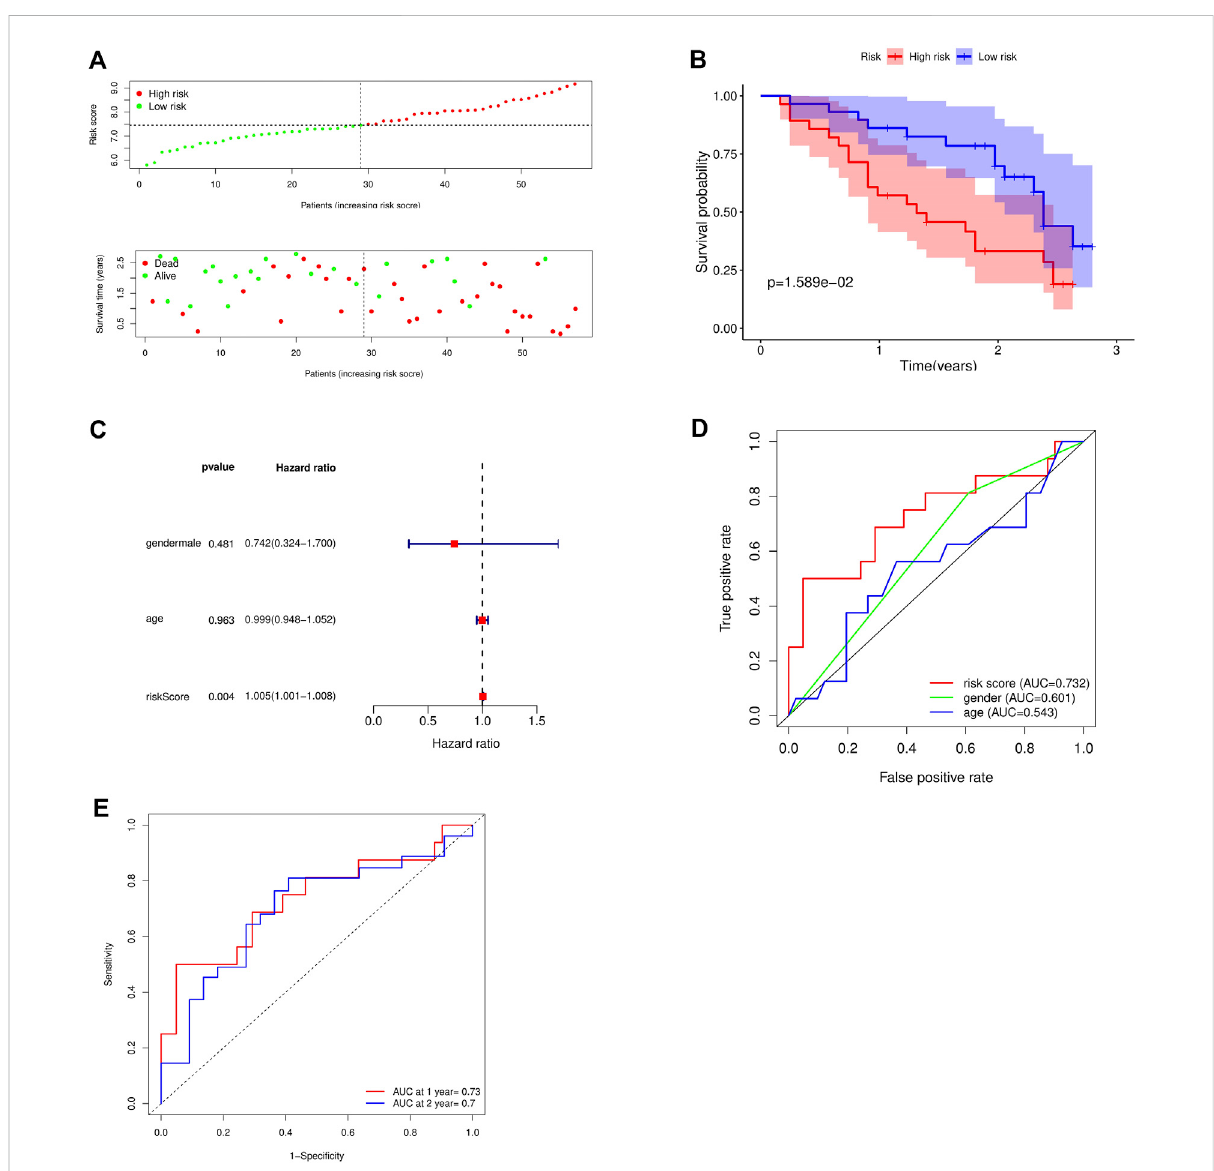
FIGURE 6 Validation of the accuracy of the prognostic model using the GSE93606 dataset. (A) Distribution of patients and risk levels in different risk groups; (B) Overall survival curve of the model; (C) Multivariate independent prognostic analysis; (D) ROC curve of different factors (age and riskscore); (E) ROC curve of different years (1, 2